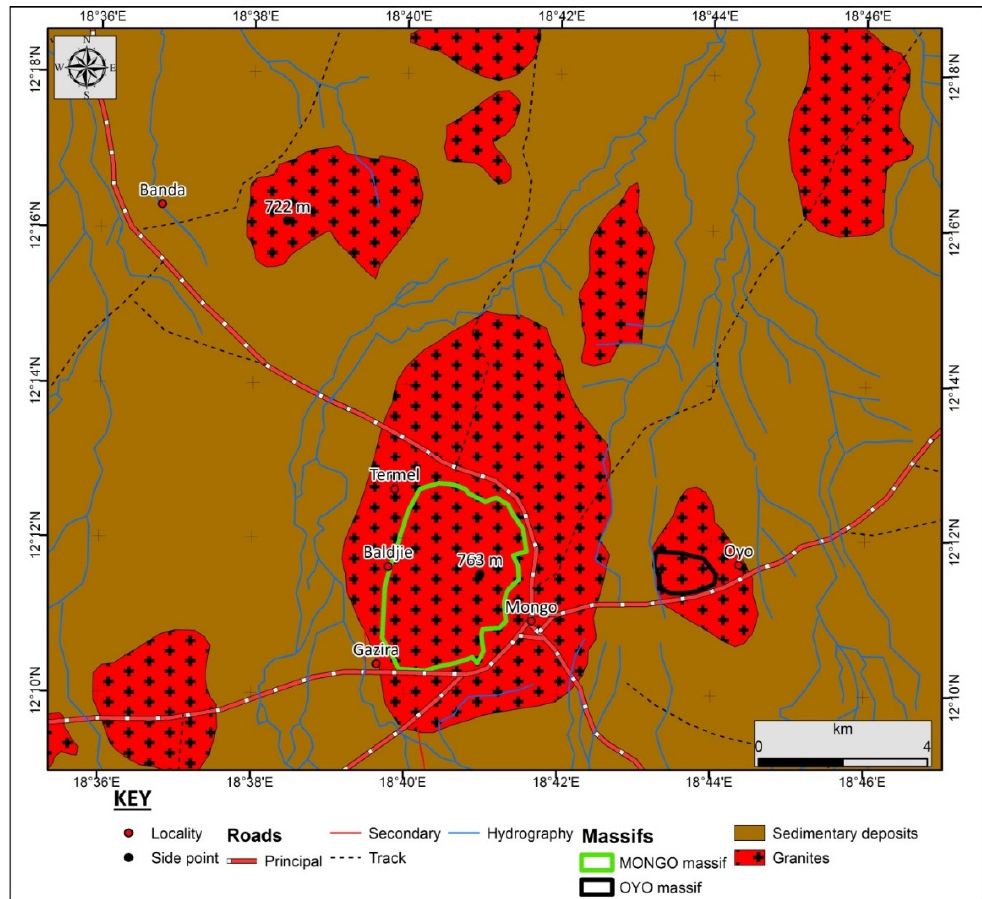
Figure 2. Geological map of the study area, redrawn after [12].